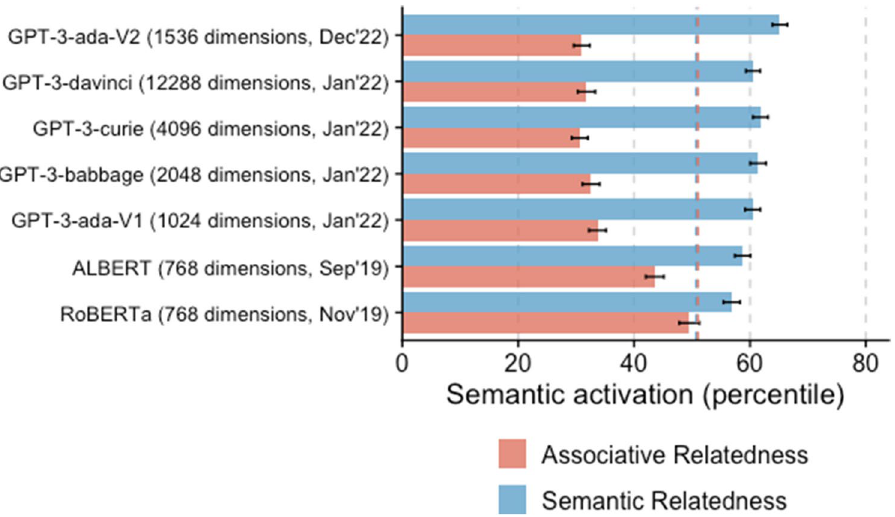
Figure 3. Semantic activation for associatively (red) and semantically (blue) related words. Dotted lines represent semantic activation for the associatively (red) and semantically (blue) related words in